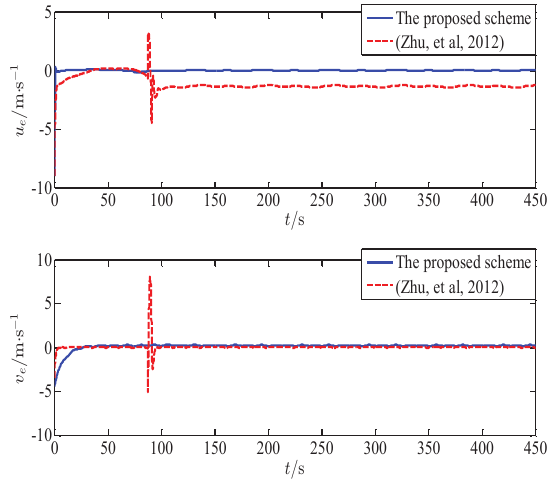
Figure 6. Velocity errors results of circular trajectory.